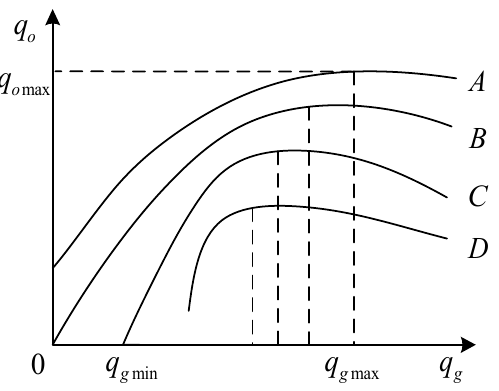
Figure 1. Types of GLPCs ( q g min , q g max are the minimum, maximum injected gas rate; ABC and D represent four different gas lift characteristic curves).